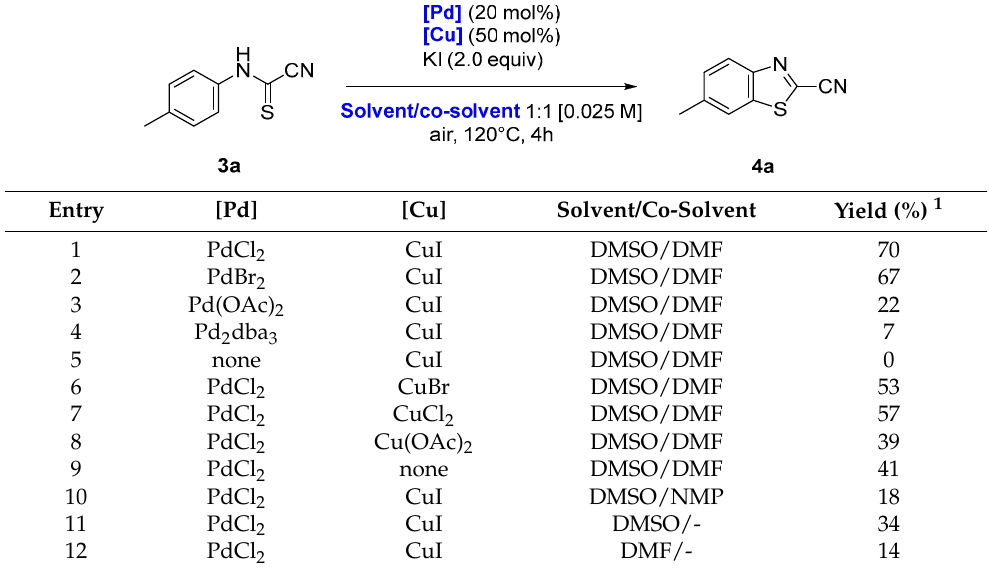
Table 3. Optimization of the palladium and copper sources as well as the solvent.